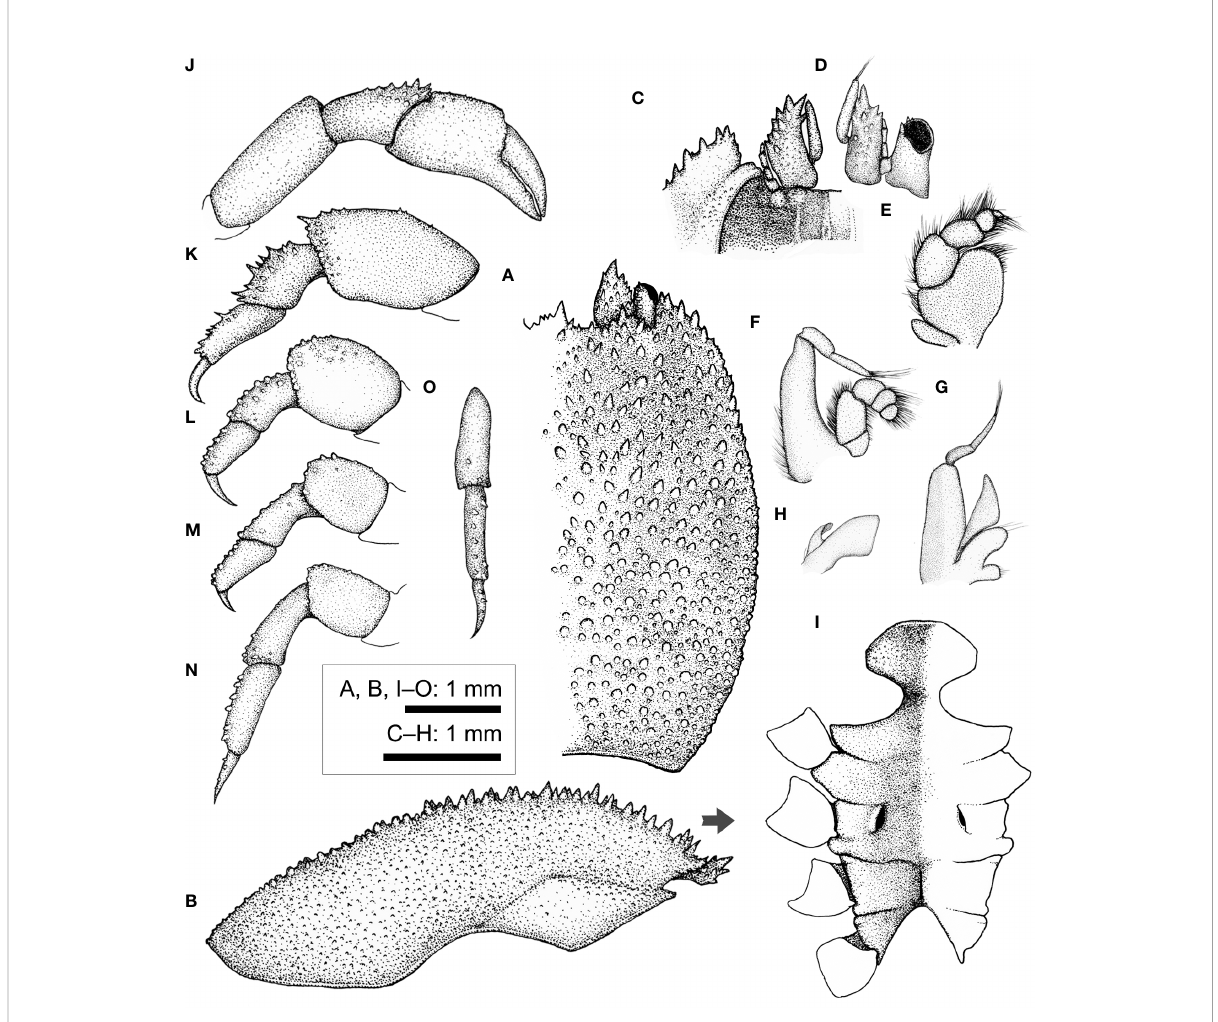
FIGURE 14 Xynomaia sheni (Fize & Serène, 1956) (CEL-Hapa-002). (A) carapace, dorsal view; (B) carapace, lateral view; (C) anterior view of carapace, ventral view; (D) left eyestalk and antenna 1 and 2; (E) right Mxp3; (F) right Mxp2; (G) right Mxp1; (H) right Mxl1; (I) thoracic sternites; (J) right P1; (K – N) left P2 to P5, dorsal view; (O) left P5, carpus to dactylus, lateral view. Arrow in (B) indicates the anterior